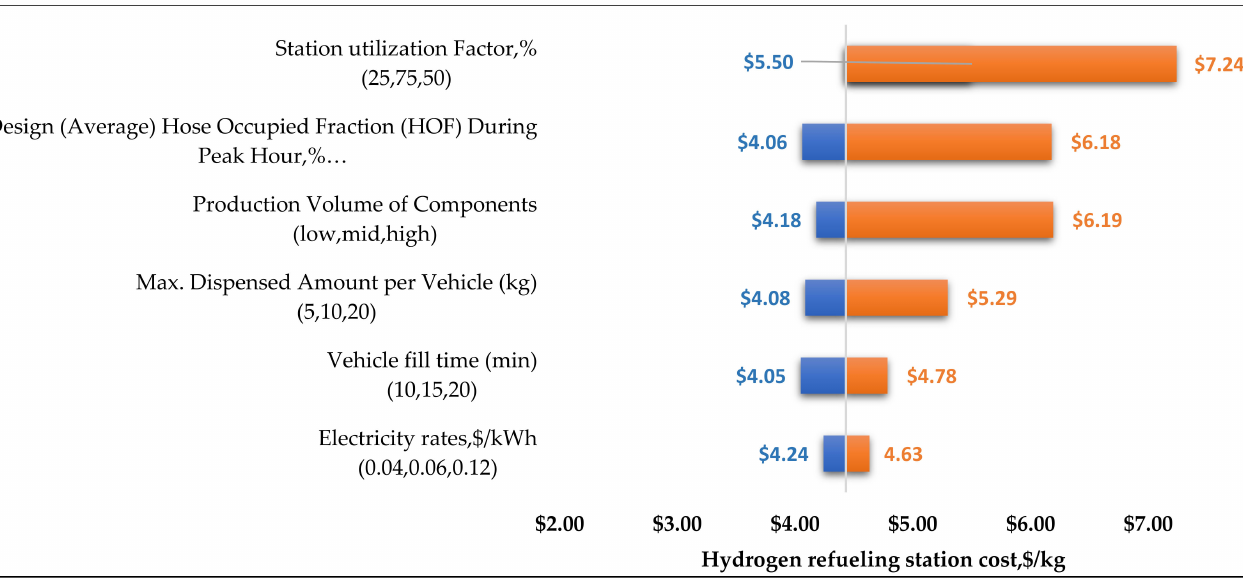
Figure 16. Range of refueling costs for a station receiving hydrogen in liquid